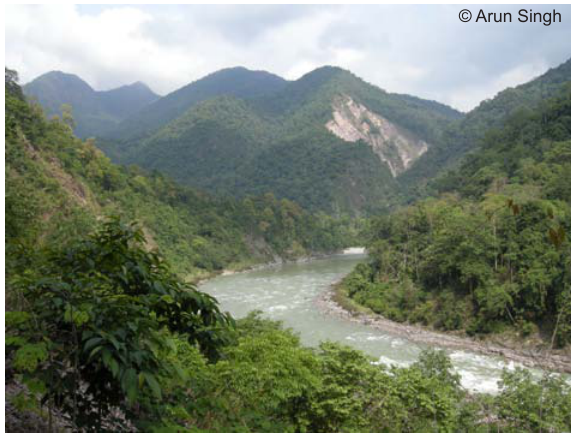
6. Low forest habitat during pre-monsoon season